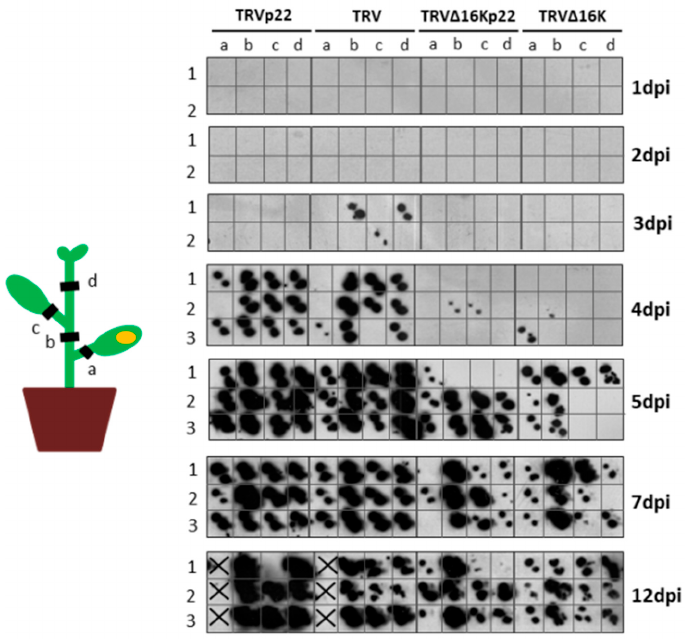
Figure 3. Analysis of the viral systemic spread in Nicotiana benthamiana plants inoculated with Tobacco rattle virus (TRV) expressing Tomato chlorosis virus p22 (TRVp22), TRV, TRV ∆ 16Kp22, and TRV ∆